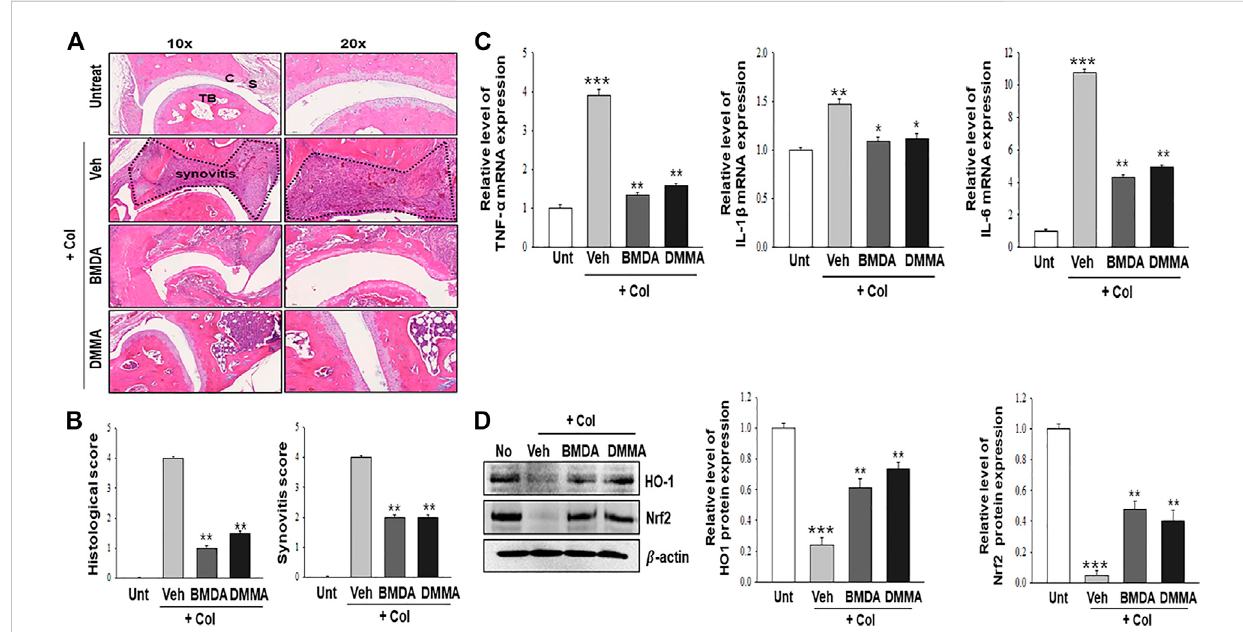
BMDA or DMMA-mediated reduction of severity is attributed to decrease of in fl ammatory cytokine transcripts and enhancement of anti-oxidation protein expression (A, B) Histopathological analysis on hind paw tissues of the animals orally treated with BMDA, DMMA, or corn oil as a control was performed with hematoxylin and eosin staining 21 days post-sensitization of collagen and IFA. Synovitis score was evaluated as described previously (Kanget al., 2020). (C) cartilage, S: synovium, TB: trabecular bone. (**; p < 0.01, Veh + Col vs . BMDA + Col,Veh + Col vs . DMMA + Col) (C) Transcript levelsofin fl ammatorycytokinessuchasTNF- α ,IL-1 β ,andIL-6weremeasuredbyqRT-PCRfromthepawtissuesoftheanimals.(ForTNF- α andIL-6qRT- PCR, ***; p < 0.001, untreatment vs . Veh + Col, **; p < 0.01, Veh + Col vs . BMDA + Col, Veh + Col vs . DMMA + Col. For IL-1 β qRT-PCR, **; p < 0.01, untreatment vs . Veh + Col, *; p < 0.05, Veh + Col vs . BMDA + Col, Veh + Col vs . DMMA + Col) (D) Expression of anti-oxidation proteins such as HO1 and Nrf2 was examined by immunoblotting and the relative expression of the proteins was analyzed after scanning using AlphaView, version 3.2.2 (Cell